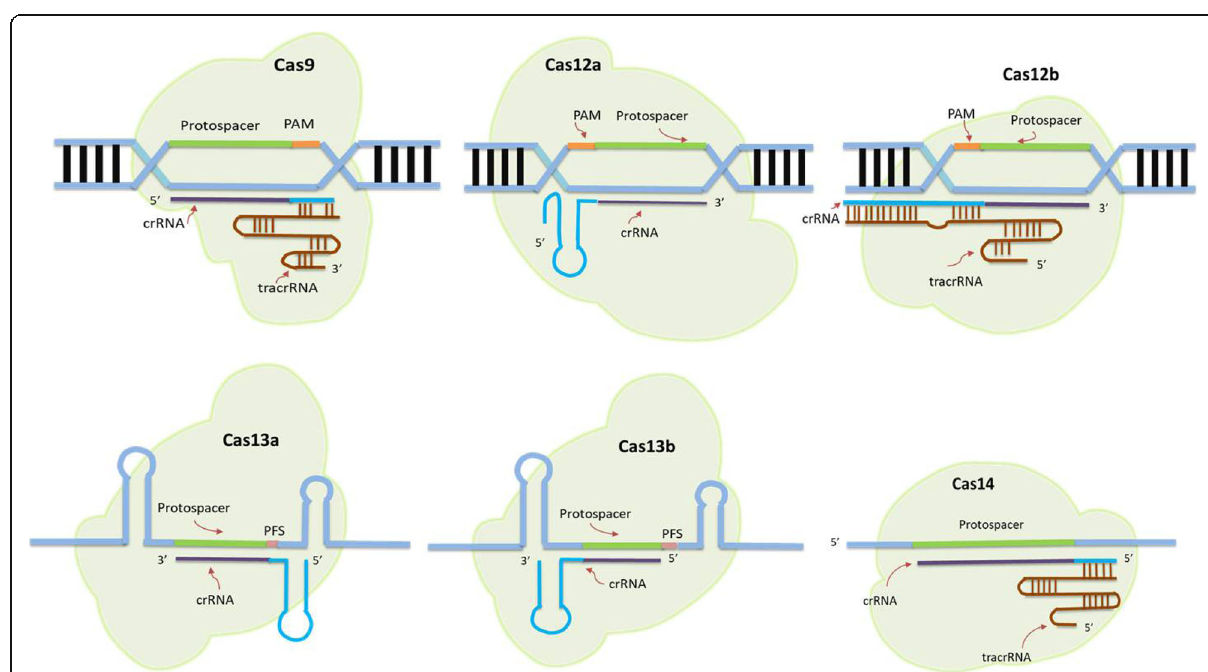
Fig. 1 Diagrammatic representation of the cleavage site architecture of different CRISPR system. sgRNA consists of a spacer (light blue), crRNA (purple) and tracrRNA (dark orange). Optimal PAMs (orange) and PFSs (red) are important for recognizing target of these corresponding systems. Cas12a, Cas12b, and Cas14 are validated subtypes in type V and each shows a distinct architecture. Only crRNA is required for Cas12a, while the other subtypes require an additional tracrRNA. Cas14 cleaves ssDNA without PAM specificity. Cas13a and Cas13b belong to subtype VI with recognition of the PFS sequence, the crRNA-Cas13 complex induces ssRNA cleavage activity. Cas9, CRISPR associated protein 9; crRNA, CRISPR RNA; sgRNA, single guide RNA; tracrRNA, transactivating CRISPR RNA; PAM, protospacer adjacent motif; PFS, protospacer flanking